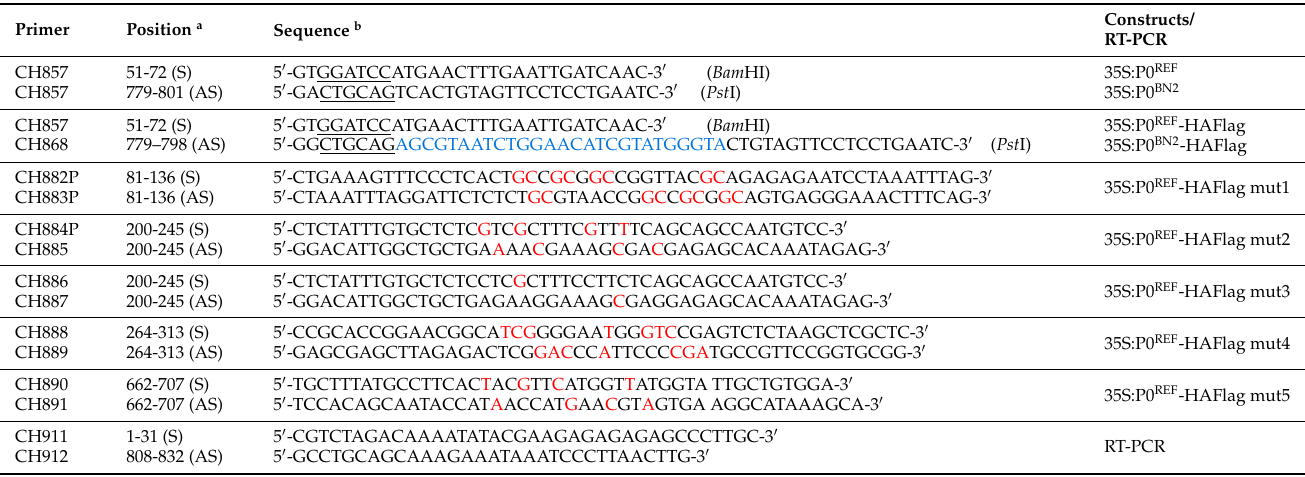
Table 1. List of primers used in this